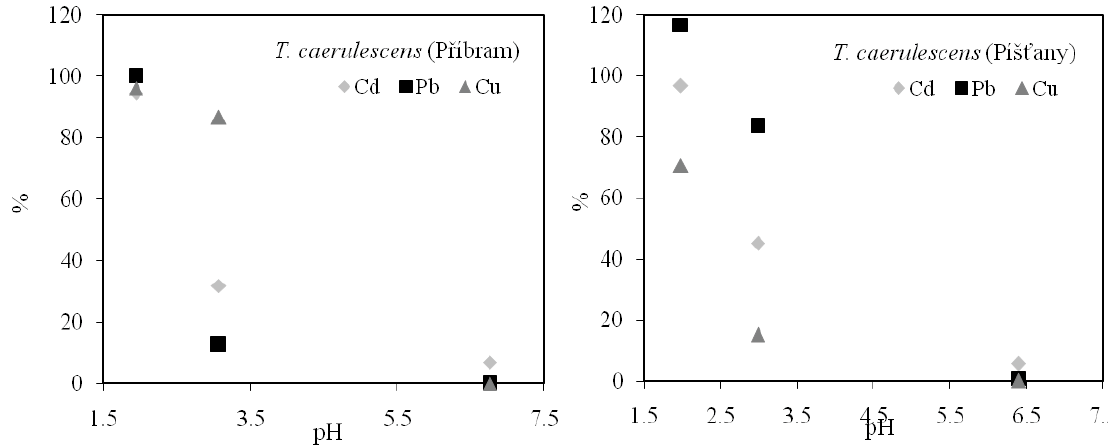
Figure 4. Dependence of ionic portion (in %) measured by DP-ASV on pH of Thlaspi caerulescens J. & C. Presl soil solution grown at two localities. The total contents of metals were measured by ET-AAS and amount to